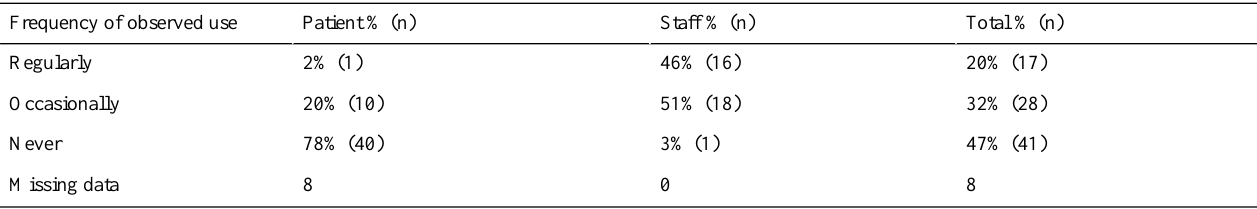
Table 1. Results for frequency of observed use of devices in the workplace/bedside by patients and